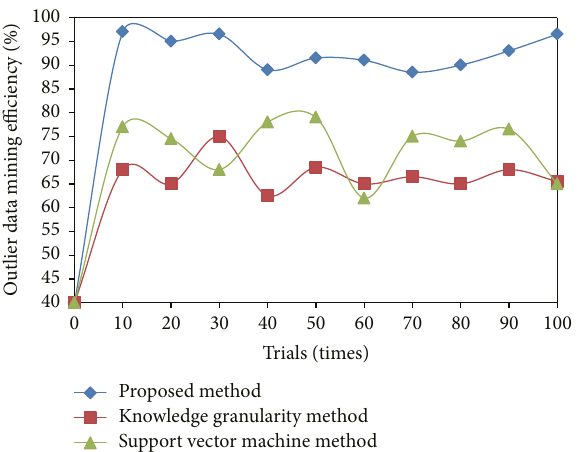
Figure 15: Comparison of outlier data mining stability.